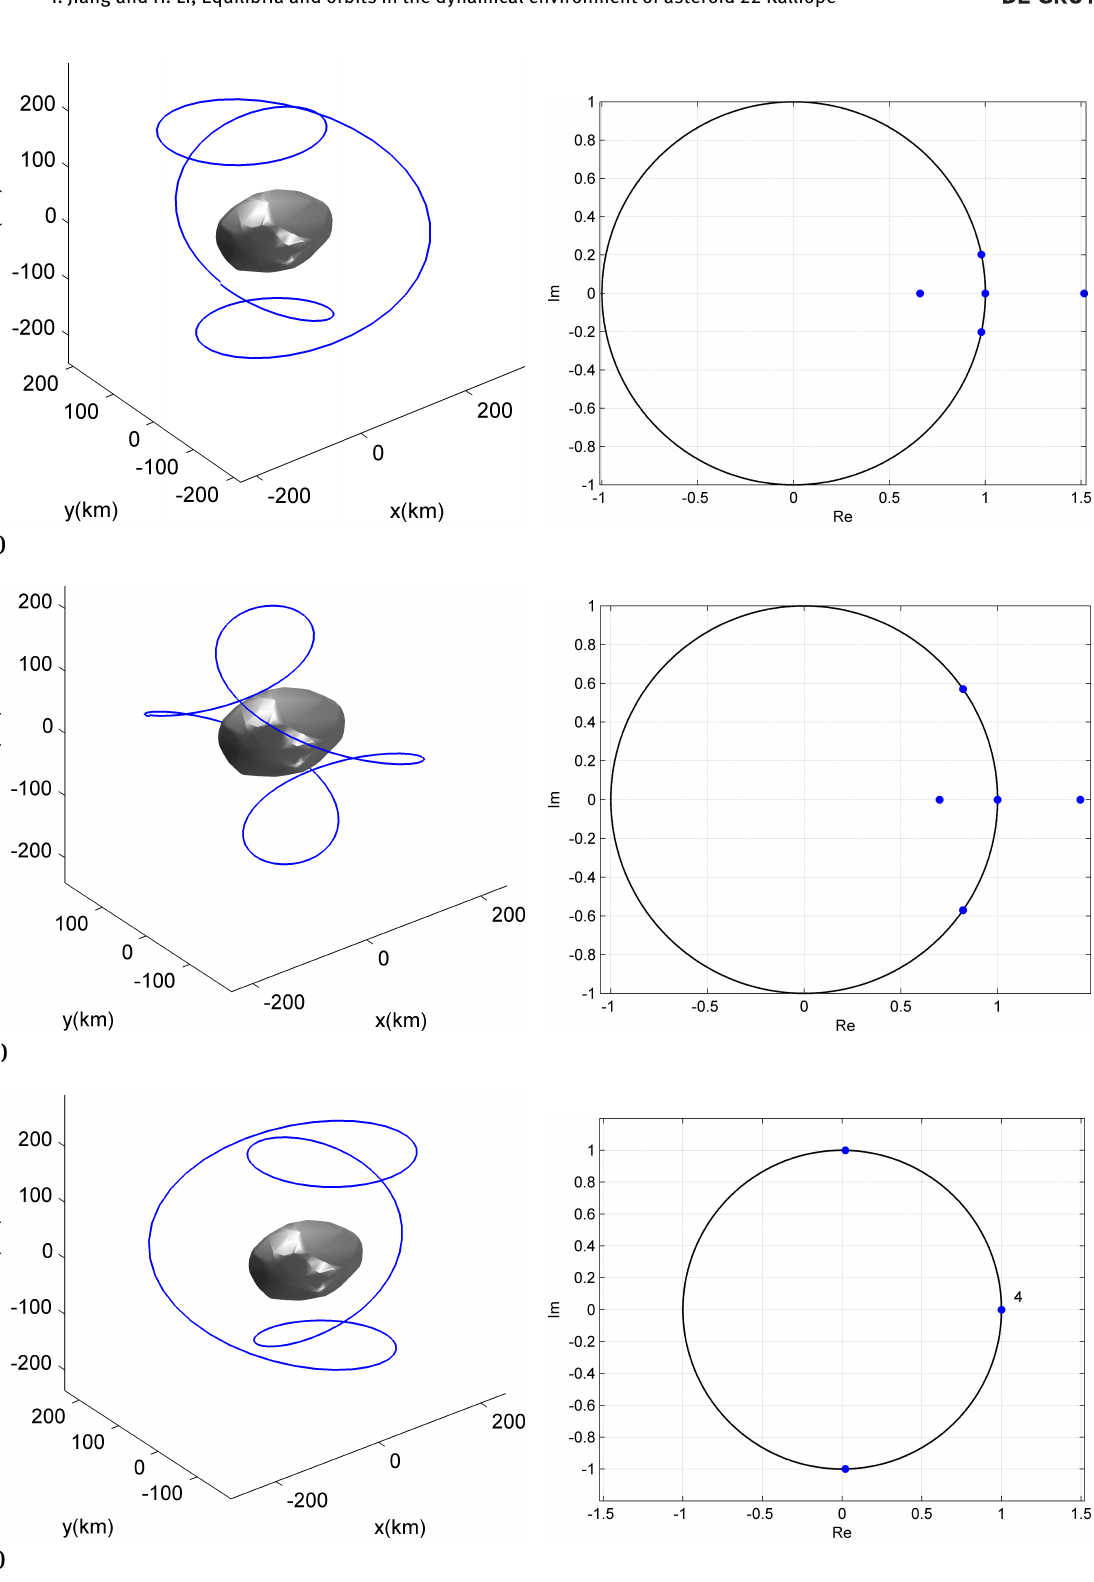
Figure 7. Periodic orbits in the potential of the asteroid Kalliope in the body-fixed frame. (a) 3D plot of the first unstable periodic orbit with 2:1 resonance and the distribution of Floquet multipliers; (b) 3D plot of the second unstable periodic orbit with 2:1 resonance and the distribution of Floquet multipliers; (c) 3D plot of a stable periodic orbit with 2:1 resonance and the distribution of Floquet